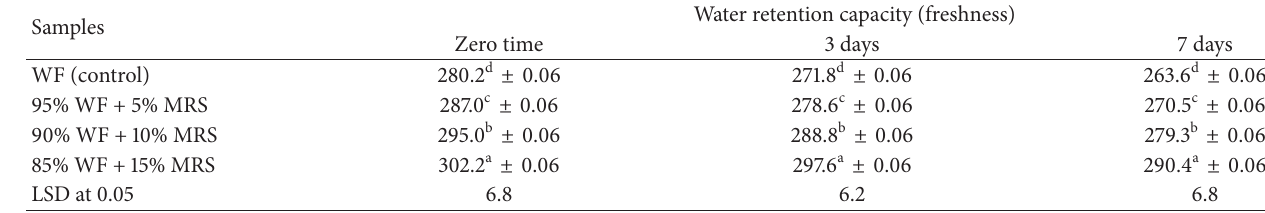
Table 7: Freshness properties of Fino bread as affected by the addition of